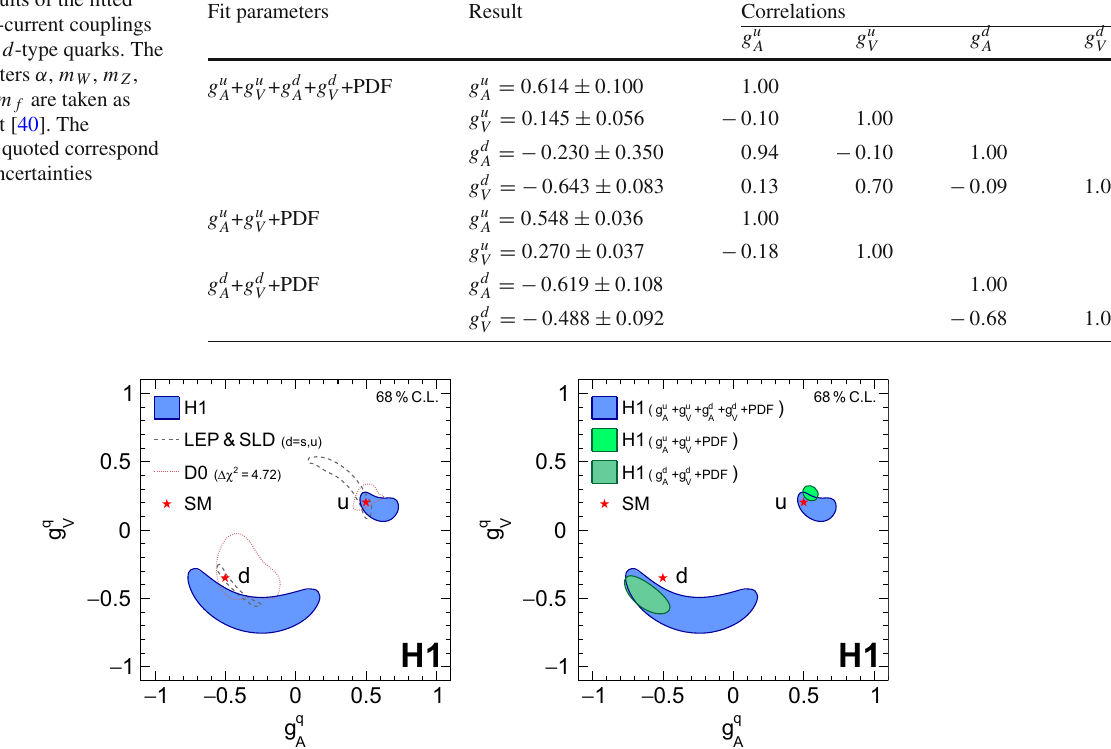
Table 3 Results of the fitted weak neutral-current couplings of the u - and d -type quarks. The other parameters α , m W , m Z , m t , m H and m f are taken as external input [40]. The uncertainties quoted correspond to the total uncertainties